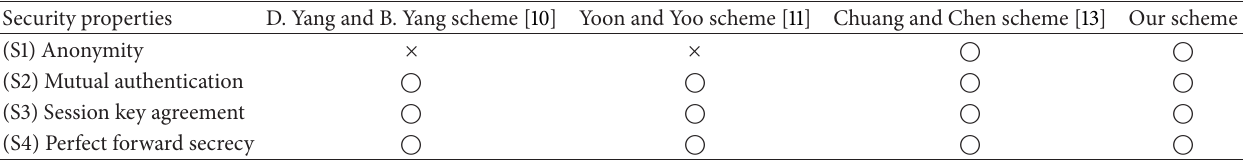
Table 1: Comparison of security